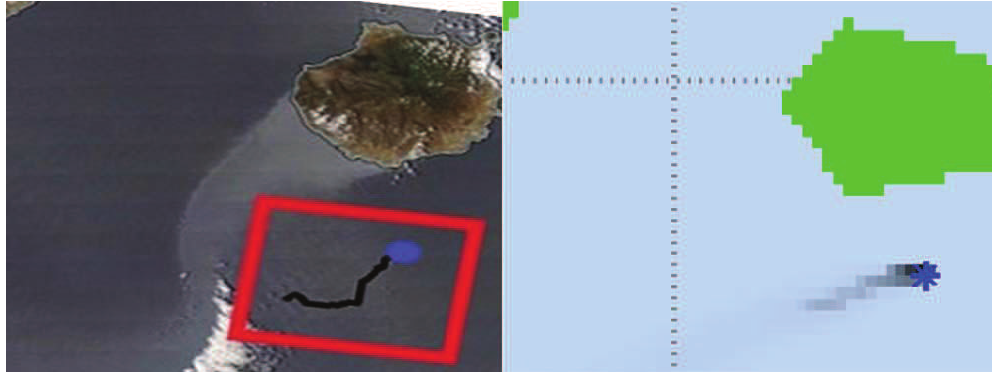
Fig. 3 (Left) NASA satellite image presenting the Oleg Naydenov oil spill situation on 21 April 2015. The zone of interest is inside the red rectangle. The ship position is represented by a blue circle and the oil spill with a black line. (Right) Oil concentration simulated by the model presented in this work at the same date, considering the computational domain Ω z . The land is represented in green and the position of the Oleg Naydenov ship by a blue